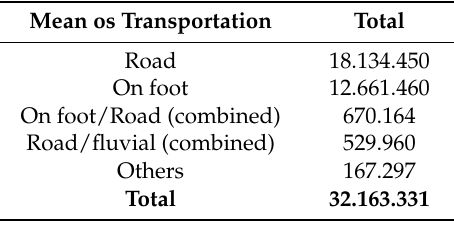
Table 3. Number of cattle moved in South Pantanal between 2007 and 2014, according to the type of transport used.